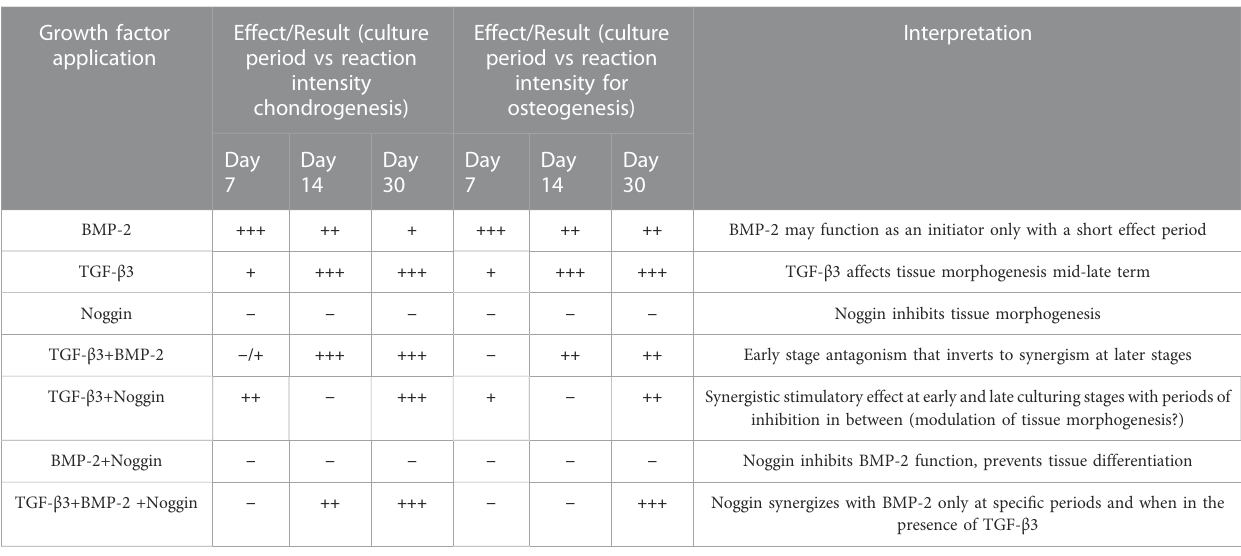
TABLE 1 The summarized results of/between these three growth